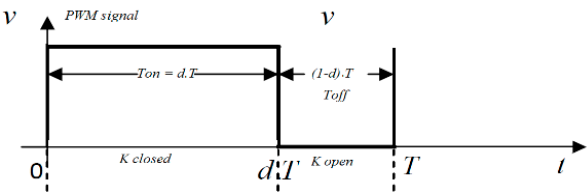
Figure A1. Pulse Width Modulation (PWM) signal controlling the switch K . From Equations (A1)–(A4), the current curve through the inductance and its voltage are represented in Figure A2.